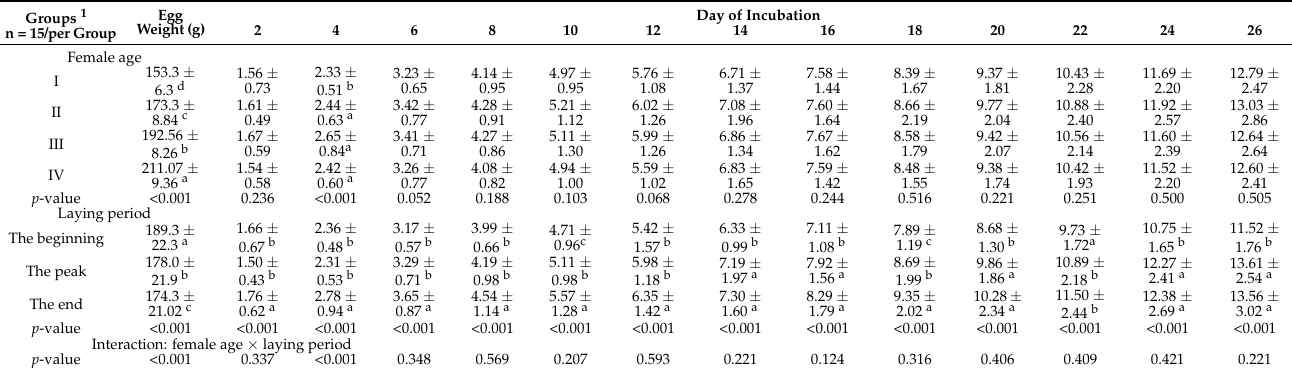
Table 5. Egg weight loss during incubation